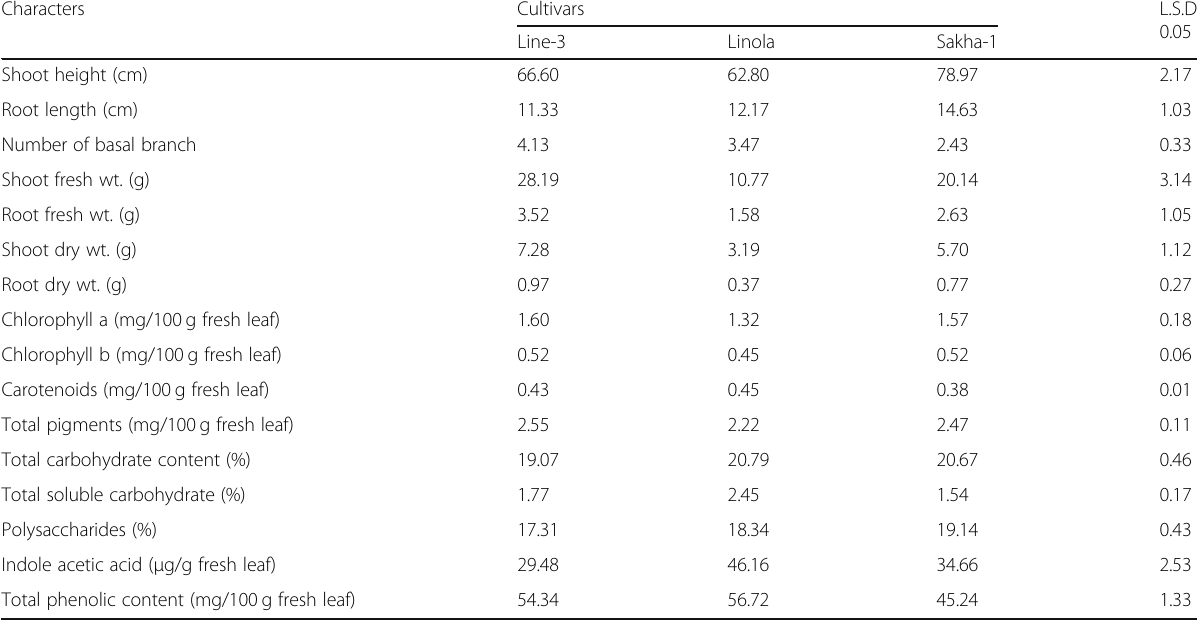
Table 3 Variations in growth parameters and chemical content between three flax cultivars grown under sandy soil conditions